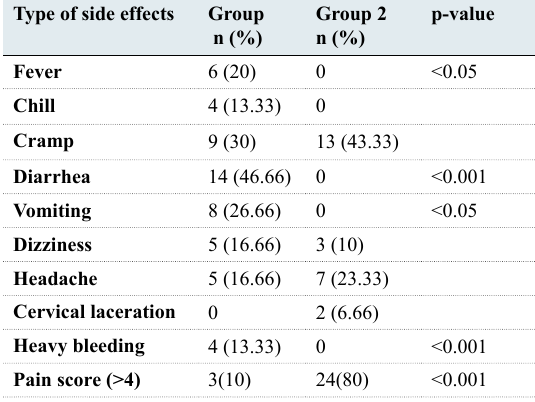
Table 2: Side effects complained by the study population Type of side effects